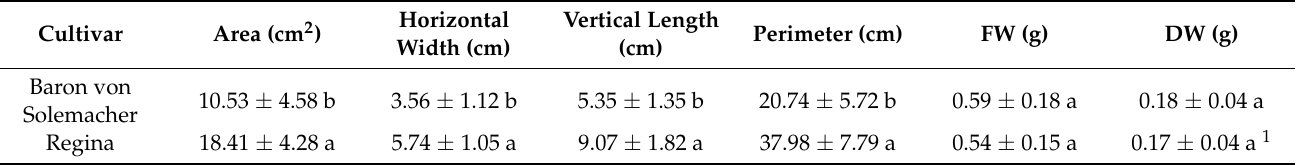
Table 2. Biometrical characteristic of leaves of two wild strawberry